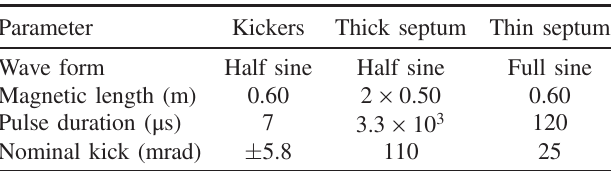
TABLE III. Main design parameters of the standard injection pulsed magnets.